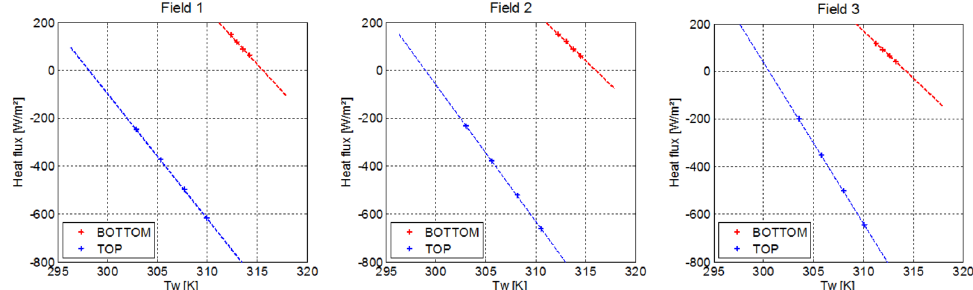
Figure 10. Linear regression (average on the whole measurement